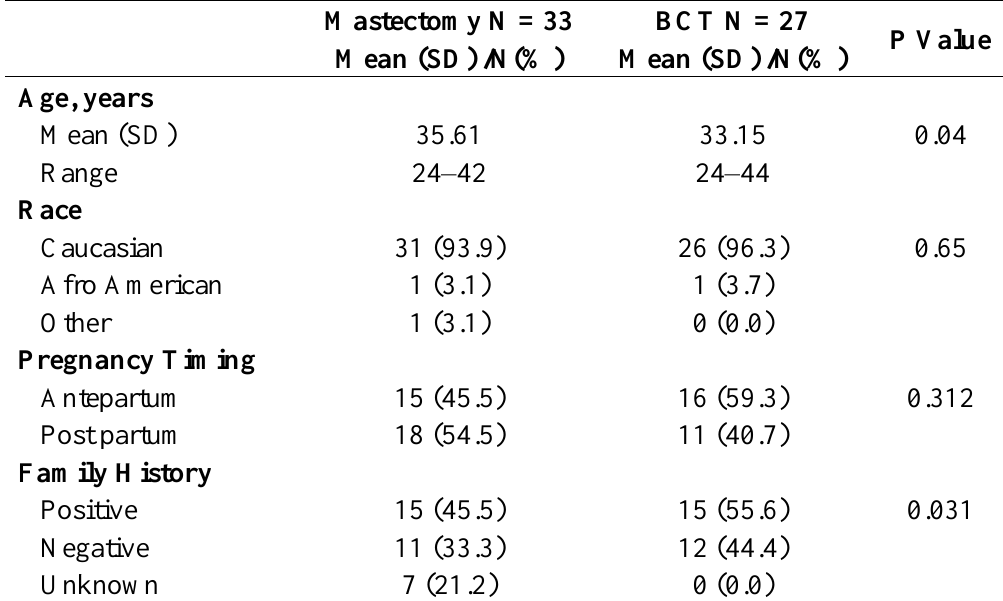
Table 1. Patient and Tumor Characteristics for both